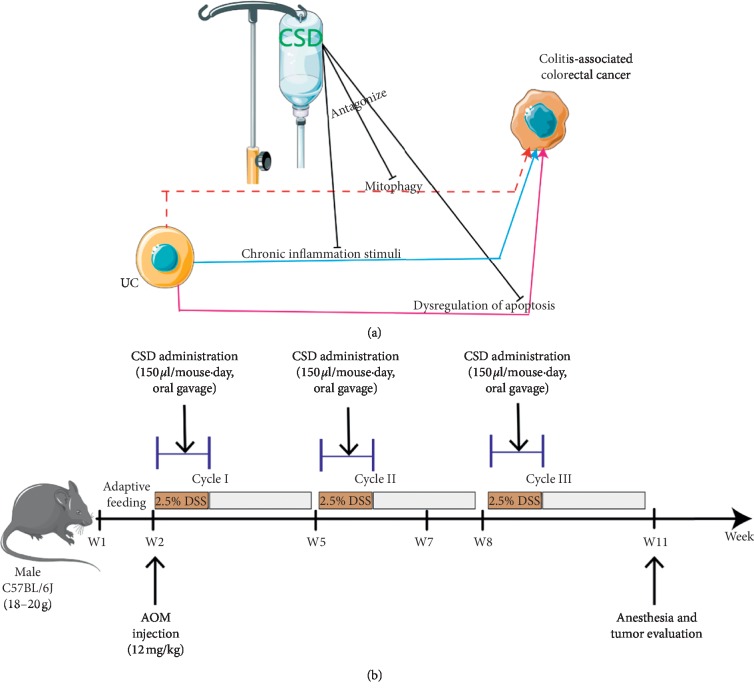
A schematic diagram of the workflow of CSD in UCRCC (a) and experimental protocol for UCRCC model and validation for investigation of the mechanisms of CSD (b).